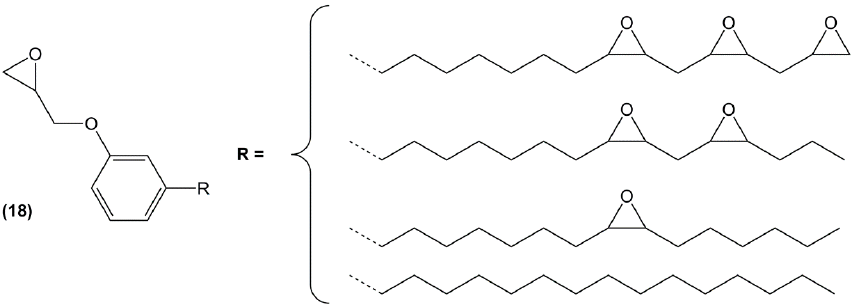
Figure 15. Theoretical structure of epoxidized cardanol.